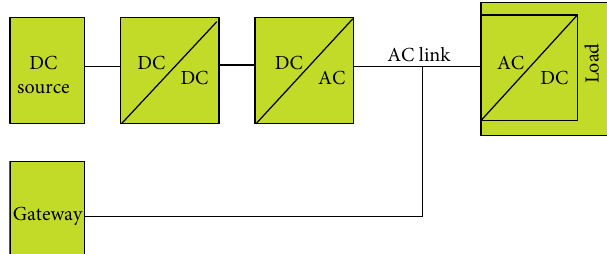
Figure 10: Basic block of diagram AC